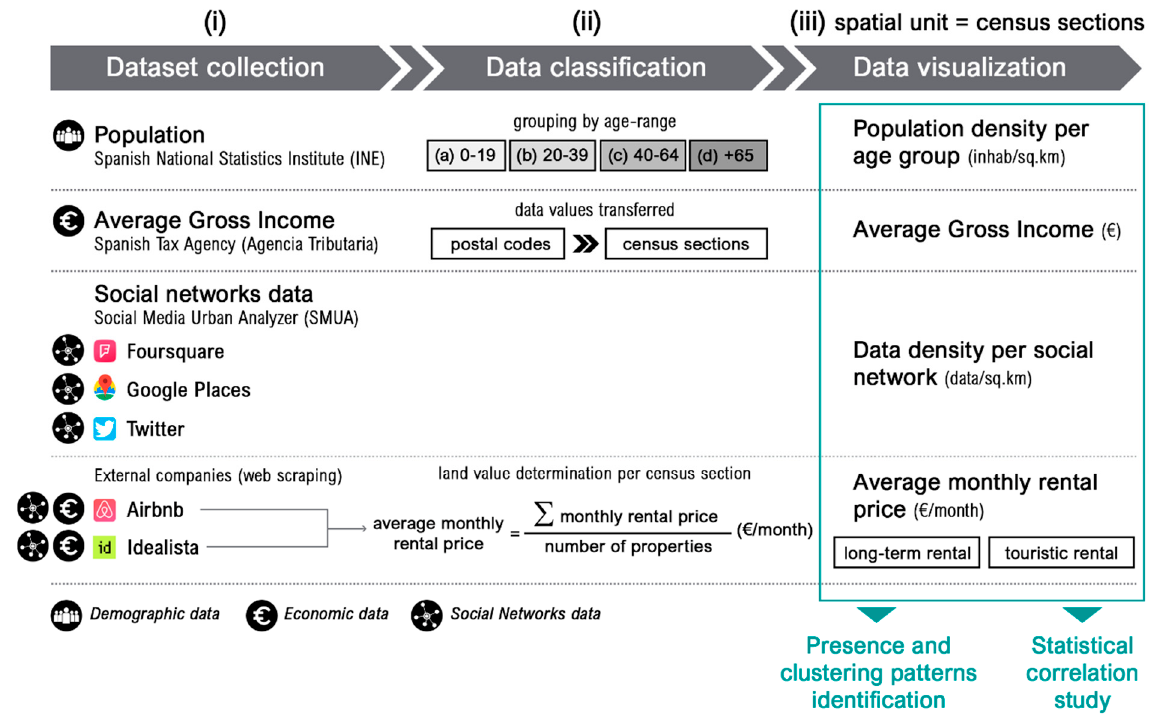
Figure 4. Overall research methodology.